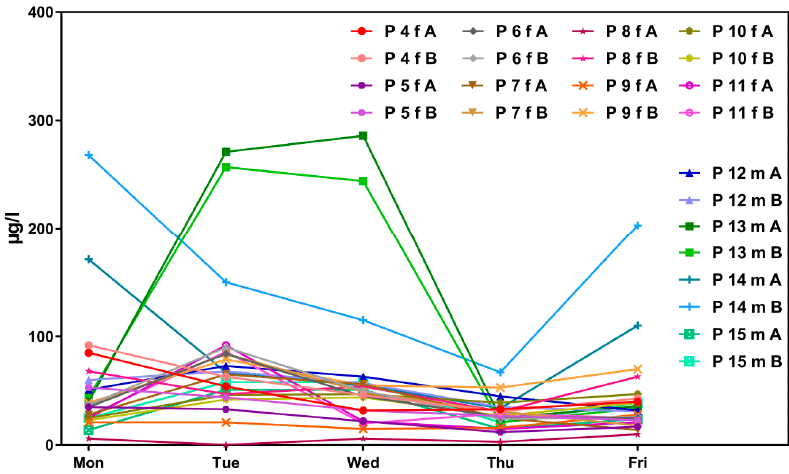
Figure 2. Variability in urinary concentrations of ∑ 5OH-MEHP + 5oxo-MEHP (A) and 5cx-MEPP (B) in morning urine of eight female (f) and four male (m) subjects at the age between 17 and 20 years (students of a boarding school) over the course of a school week. The number starting with “P” is the subject identifier.